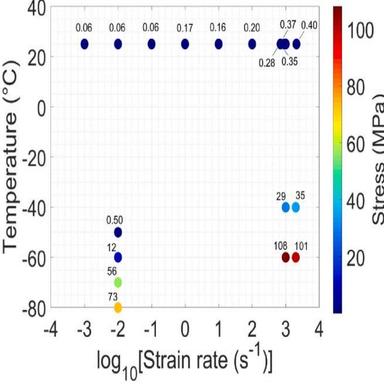
Strain rate and temperature dependence on the peak stress for U-NR.